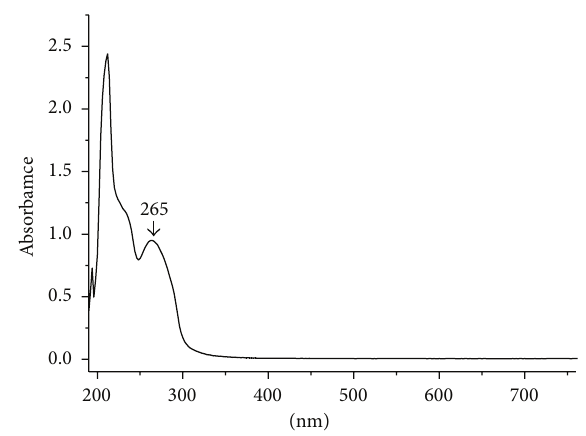
Figure 4: UV spectrum of